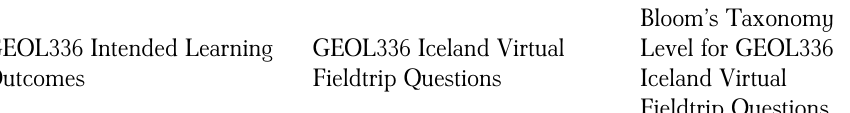
Table A3: Alignment of the VTF Krafla intended learning outcomes, the intended learning outcomes from the third-year under- graduate volcanology and magmatic systems course, and the associated Bloom’s taxonomy